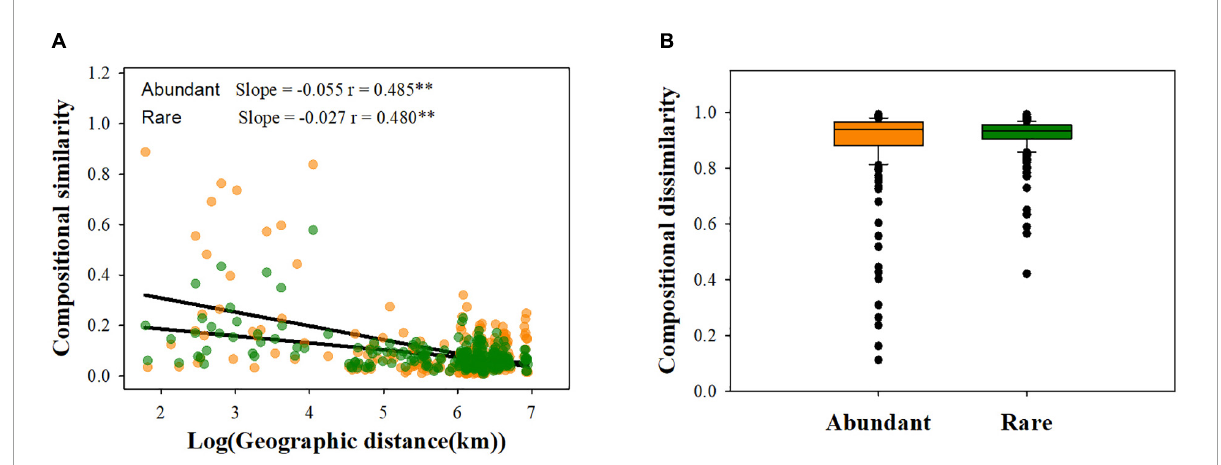
FIGURE3 Patterns of rare and abundant fungal β -diversity. (A) Distance- decay curves of community similarity for rare and great fungi; (B) fungal β -diversity between rare and abundant subcommunities. ∗∗ P <